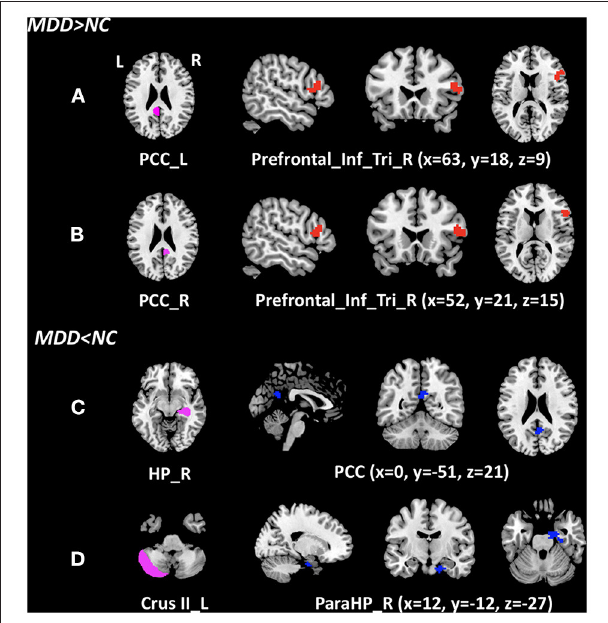
FIGURE 1 | Clusters of between-group differences of z-score of the FC with age, gender, education level, and center adjusted ( P < 0.05, FWE corrected). Compared to the NCs, significantly increased z-score of the FCs in MDD patients were found between (A) the left posterior cingulate cortex and the right inferior frontal gyrus (triangular part); (B) the right posterior cingulate cortex and the right inferior frontal gyrus (triangular part); significantly decreased z-score of the FCs in MDD patients were found (C) the right hippocampal gyrus and the PCC; and (D) left cerebellum Crus II and right parahippocampal gyrus. MDD, major depressive disorder; NC, normal control; cluster in red indicates the increased FC with the ROI, while blue indicates the decreased FC; PCC_L, left posterior cingulate cortex; PCC_R, right posterior cingulate cortex; Prefrontal_Inf_Tri_R, right inferior frontal gyrus (triangular part); HP_R, right hippocampal gyrus; Crus II_L, left Crus II in the cerebellum; PareHP_R, right parahippocampal gyrus; x, y, z, Montreal Neurological Institutes coordinates; L, left; R,